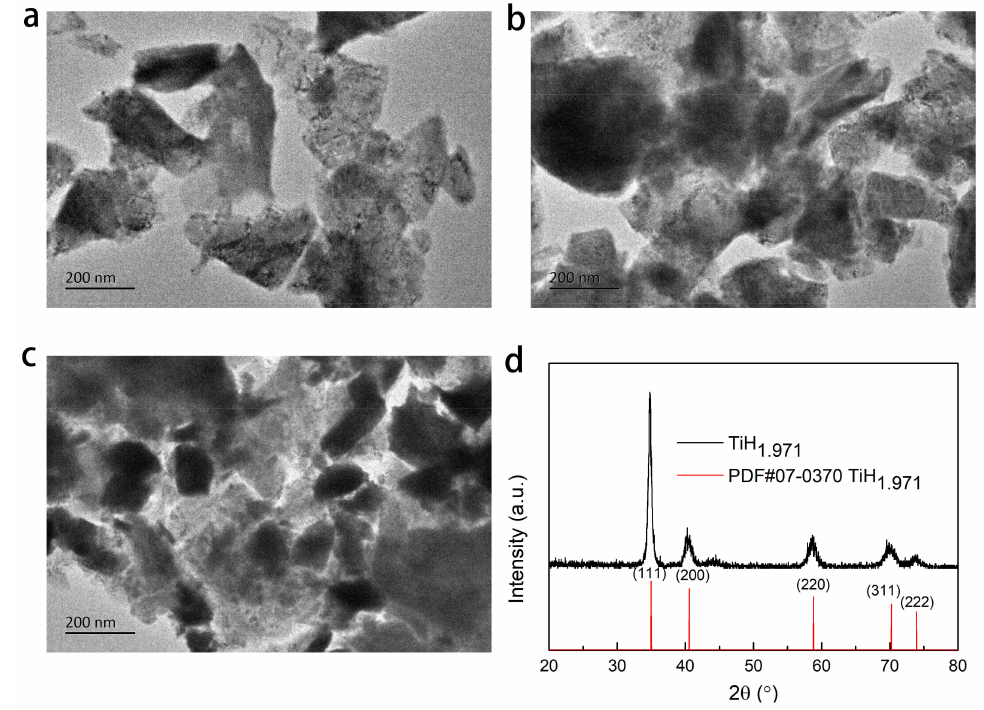
Figure 1. TEM of TiH 1.971 milled for 30 ( a ), 45 ( b ), 60 ( c ) hours and XRD pattern of TiH 1.971 milled for 60 h ( d